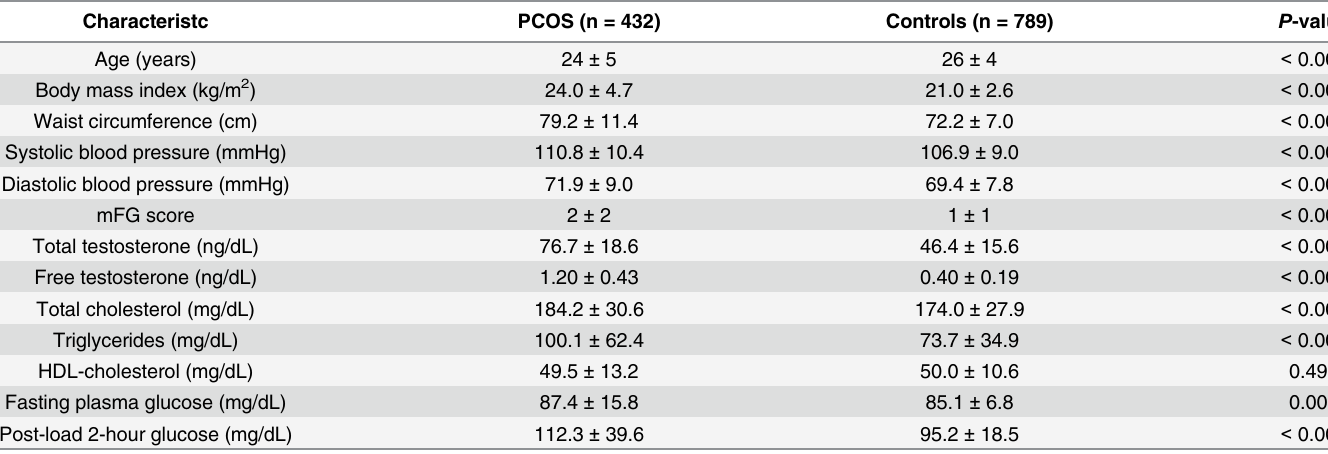
Table 1. Clinical and biochemical characteristics of the women with polycystic ovary syndrome and controls included in this study.